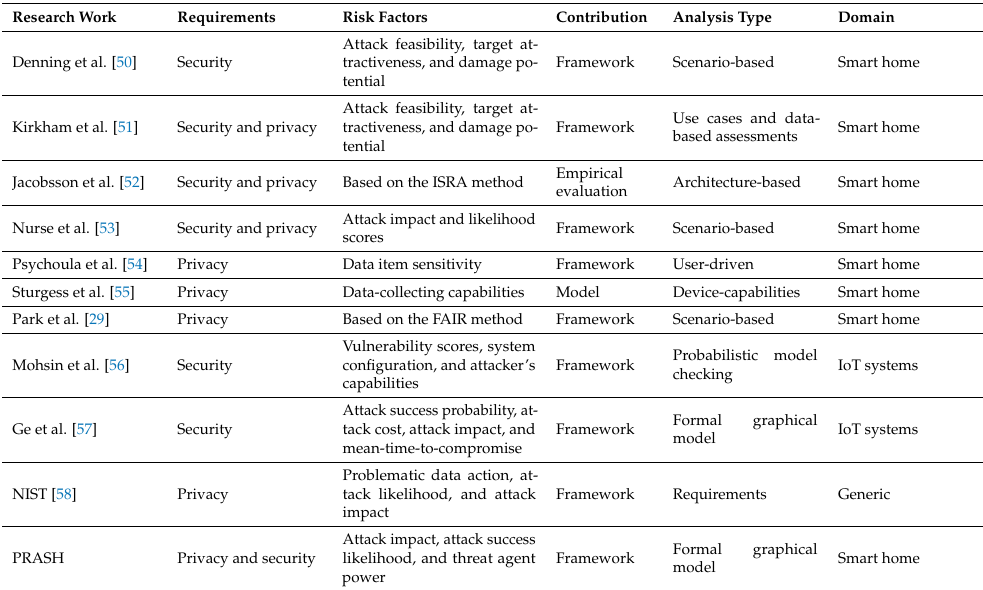
Table 2. Contributions of PRASH in relation to the existing research work on smart homes and IoT-applicable risk analysis models and